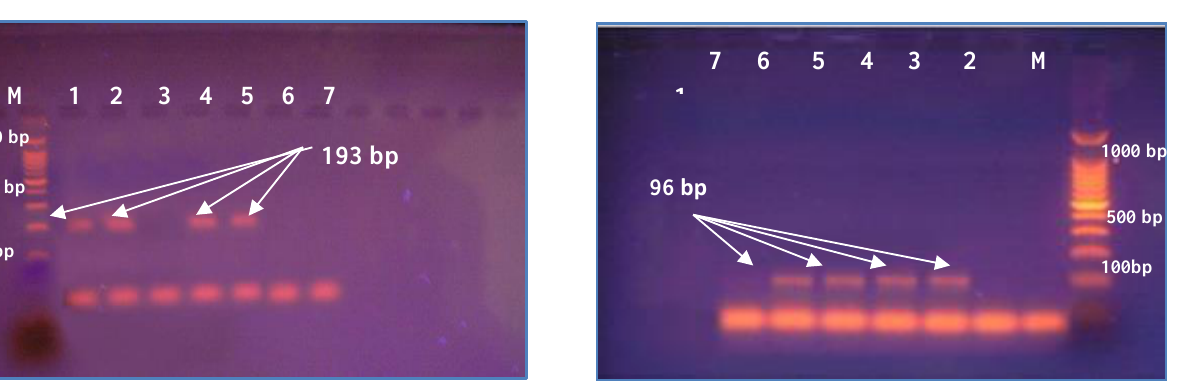
Figure, 1: First run of n PCR (amplification of 193bp fragment B1 gene of T. gondii DNA from blood sample of the infected women, sheep and control subjects). Lane-M is molecular marker (100 bp) Lanes 1-2 positive women (CM) and (MW) respectively, Lanes 3 negative women samples. Lanes 4-5 positive sheep (CM) and (MW) respectively, Lanes 6 negative sheep samples.Lanes 7 negative control samples at 193bp in the first round of n PCR.Running conditions: Agarose gel (1.5%), 5 volt/cm² for 2 hrs, stained with ethidium